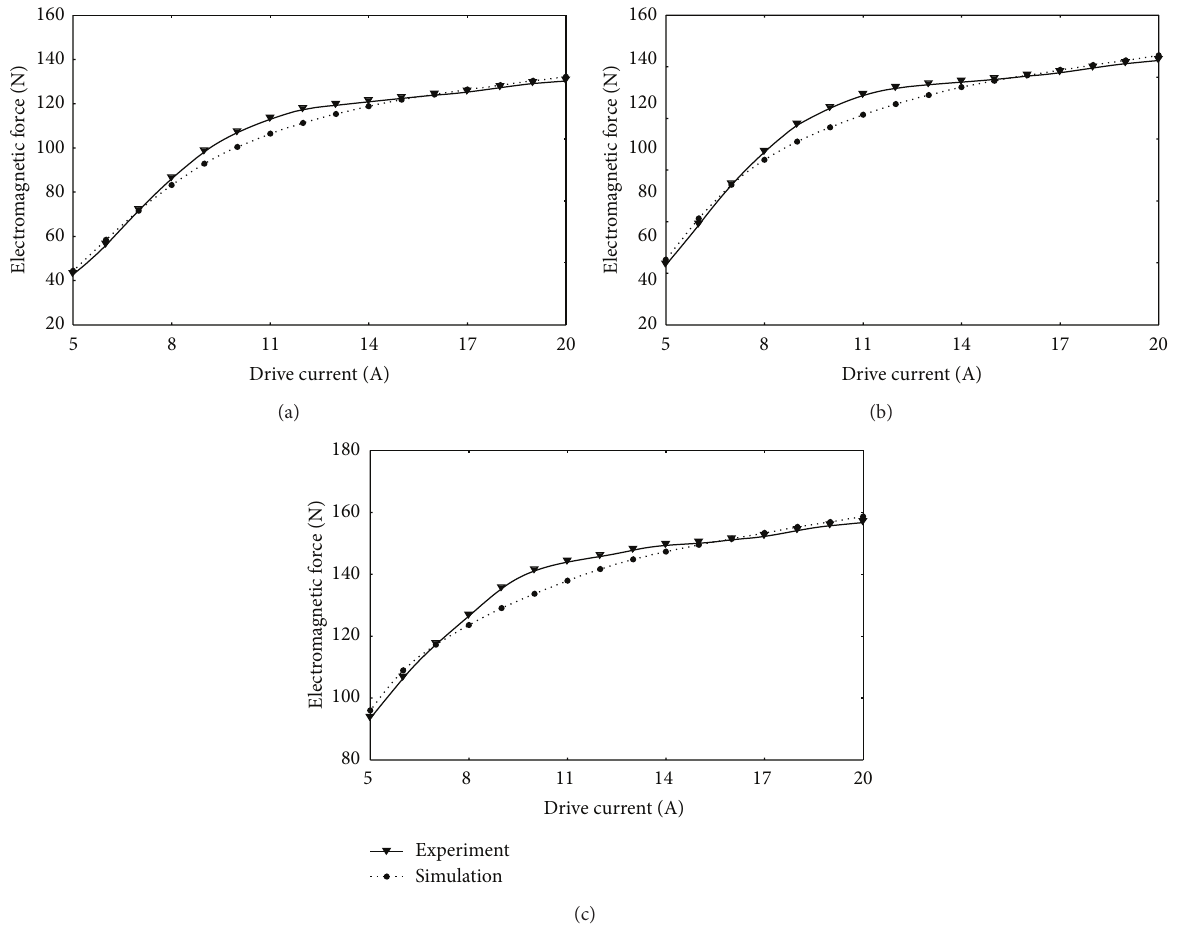
Figure 7: Comparison of experimental and simulated electromagnetic force at working air gaps of (a) 0.2mm, (b) 0.15 mm, and (c)